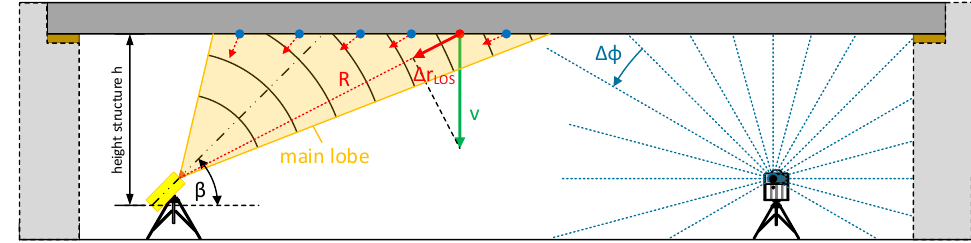
Figure 1. Schematic illustration showing the application of microwave interferometry and profile scanning for the deformation monitoring of